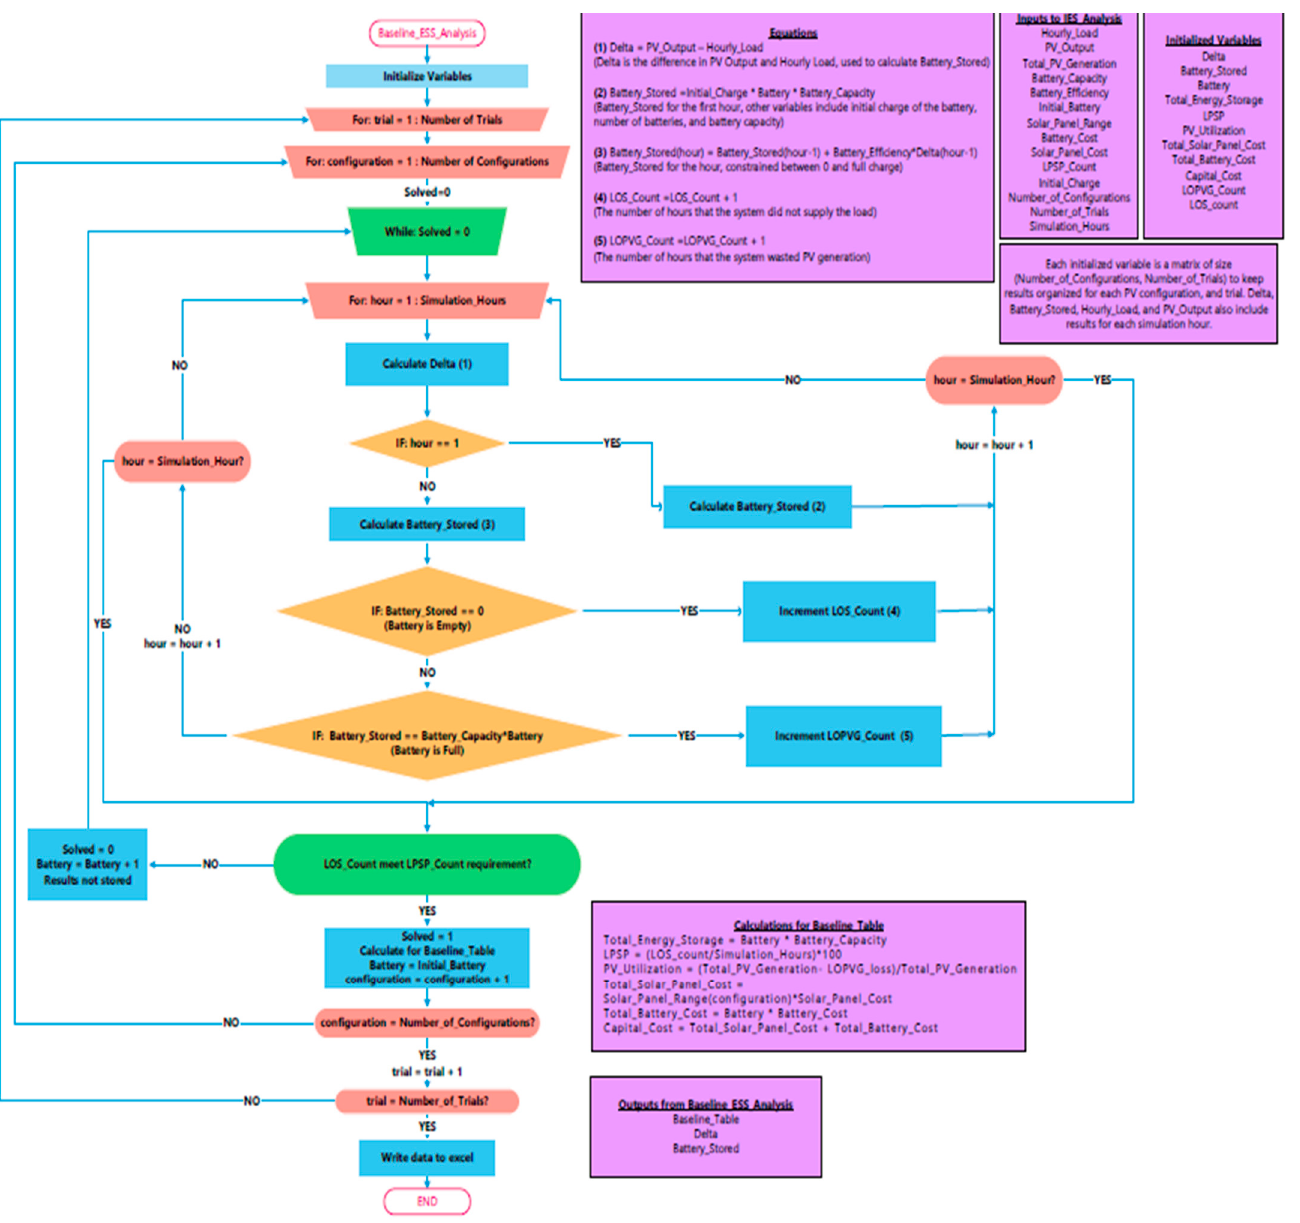
Figure A4. Flow chart describing “Baseline ESS Analysis.m”. “Central ESS Analysis.m” operates almost exactly the same way, but PV generation and hourly load are combined for each trial. Final output is a table of results with Capital Cost, Total Energy Storage, LPSP, and PV Utilization.